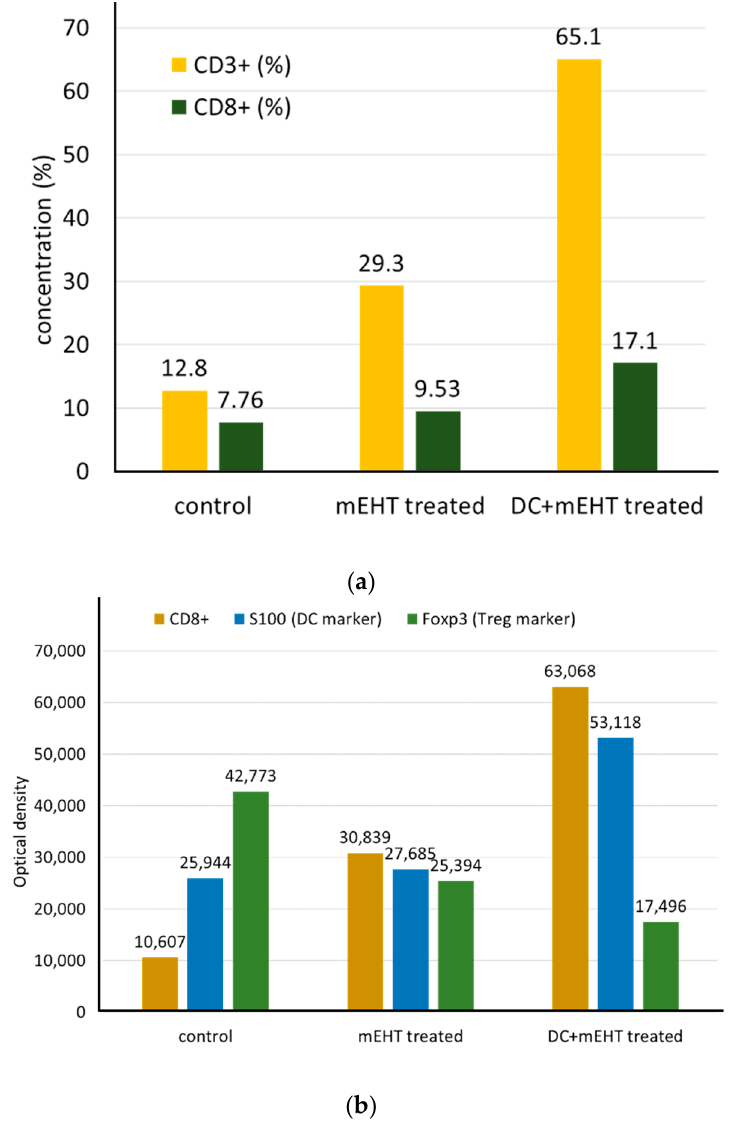
Figure 14. The mEHT treatment produced increased CD3 (cid:2878) and CD8 (cid:2878) cells, and the addition of im- manentizing DC therapy enhanced this. ( a ) The distribution of CD3 (cid:2878) and CD8 (cid:2878) T-cells shows in- creased concentration after mEHT. ( b ) The optical density measurements of S100 DC and Foxp3 T (cid:2928)(cid:2915)(cid:2917) markers show the increased antitumor immune activity of mEHT and the addition of DC en- hances the